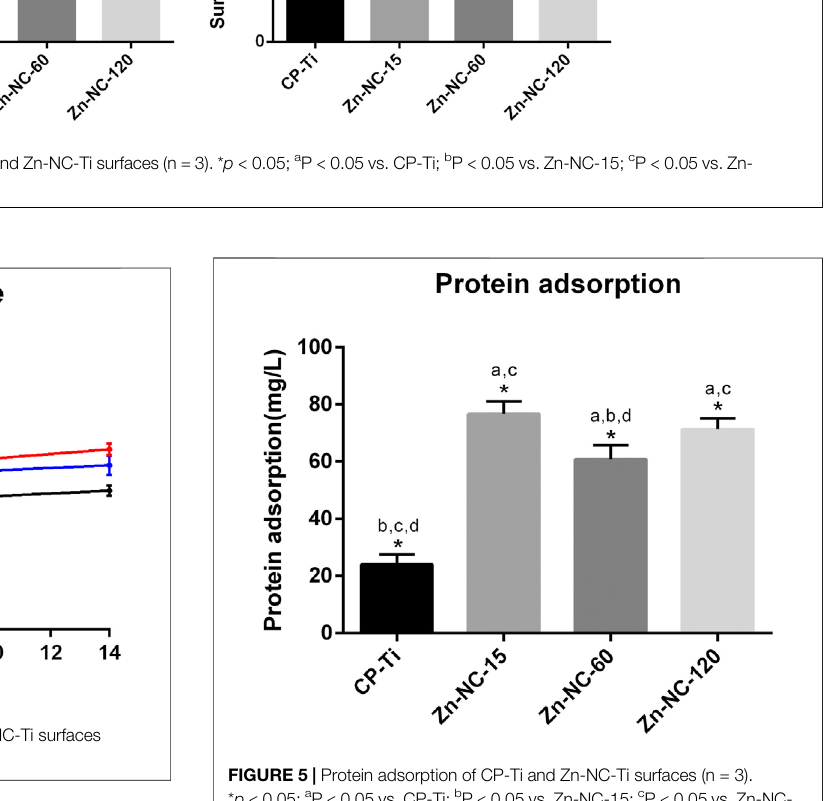
FIGURE 5 | Protein adsorption of CP-Ti and Zn-NC-Ti surfaces (n (cid:2) 3). * p < 0.05; a P < 0.05 vs. CP-Ti; b P < 0.05 vs. Zn-NC-15; c P < 0.05 vs. Zn-NC- 60; d P < 0.05 vs.